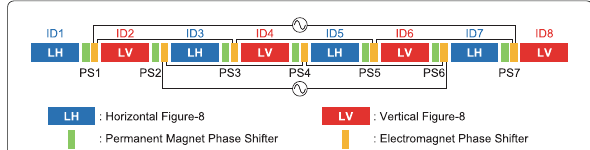
Fig. 6 Schematic layout of the SCU installed in SPring-8 BL07LSU. Four horizontal and four vertical figure-8 undulators are arranged alternately with seven PSs between each segment. Two types of PSs are installed: PMPSs and